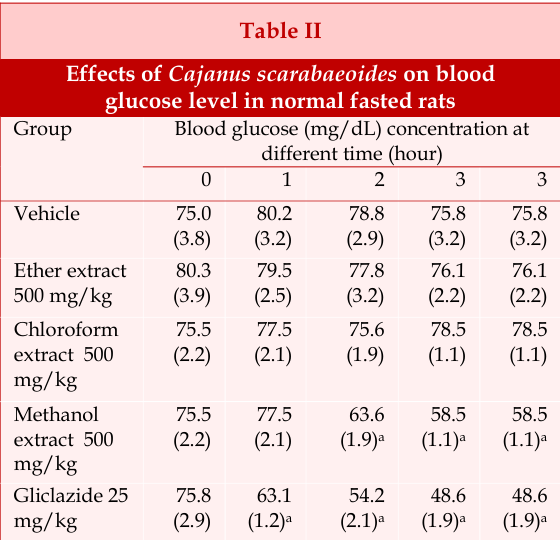
Effects of Cajanus scarabaeoides on blood glucose level in normal fasted